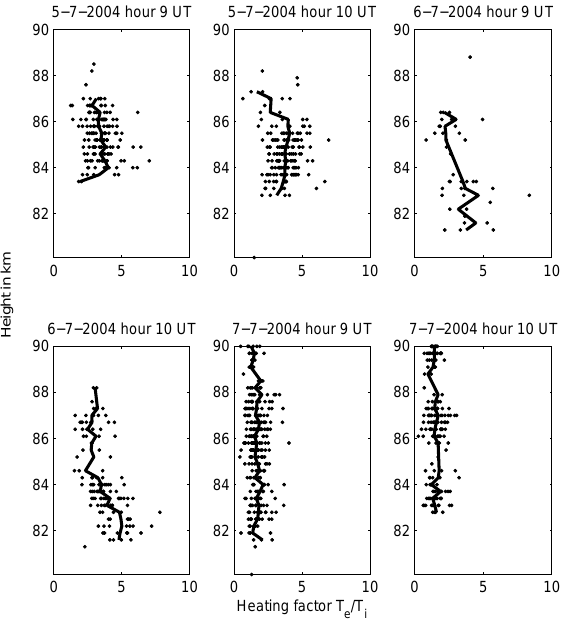
Fig. 12. The heating factors and their averages as a function of height, are plotted for two hours on each of the dates 5, 6 and 7 July